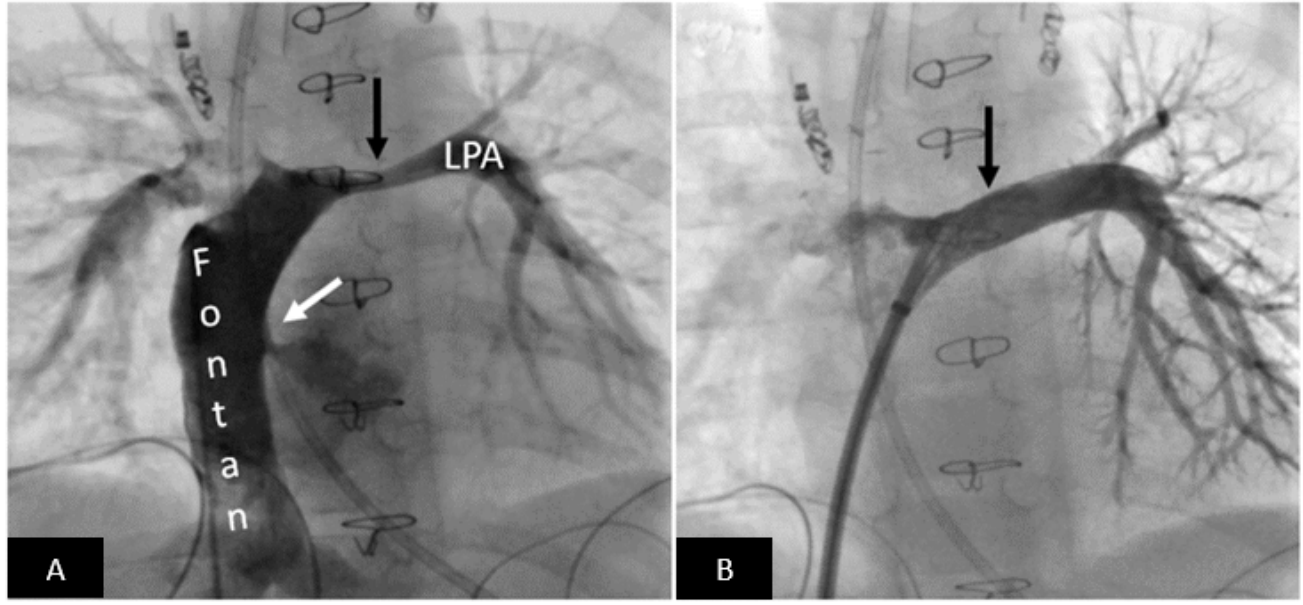
Figure 5. Postoperative left pulmonary artery stenting in a patient with persistent high-volume chest tube output after Fontan procedure. ( A ) Angiography in the Fontan pathway shows moderately severe long-segment left pulmonary artery stenosis (black arrow). Please note right to left shunt across the fenestration (white arrow). ( B ) Excellent angiographic result after stent implantation (arrow) resulting in resolution of the high-volume chest tube output. LPA = left pulmonary